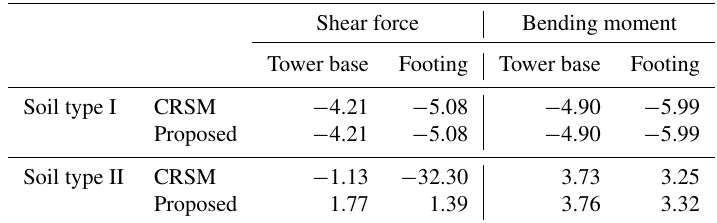
Table 6. Prediction errors (%) in the seismic